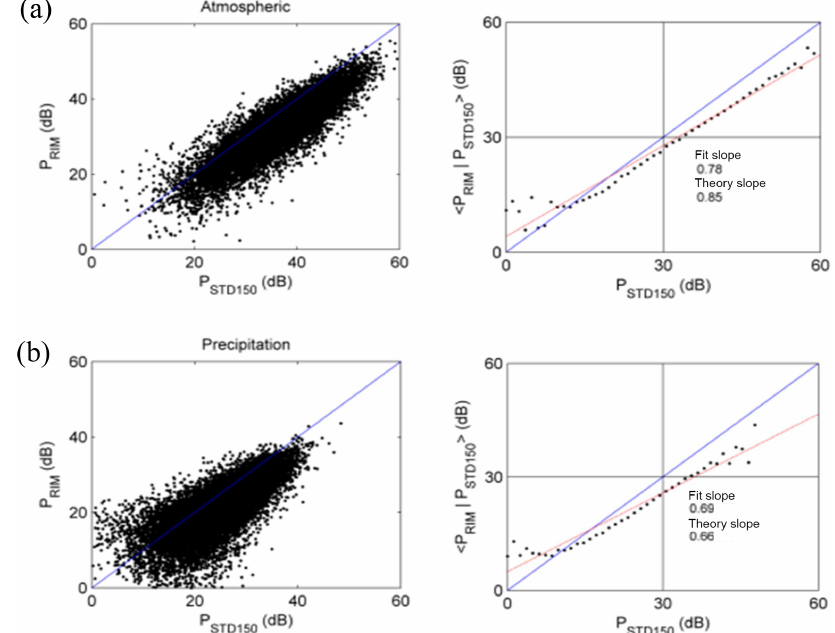
Figure 6. (a) Results of the conditional averaging (cid:104) P RIM /P STD150 (cid:105) for atmospheric echoes in the height range from 1650 to 3500ma.g.l. (b) Same as (a) but for precipitation echoes. Data time and date: 18:48:40–19:17:20UT, 21 August 2013 (red line is the fit